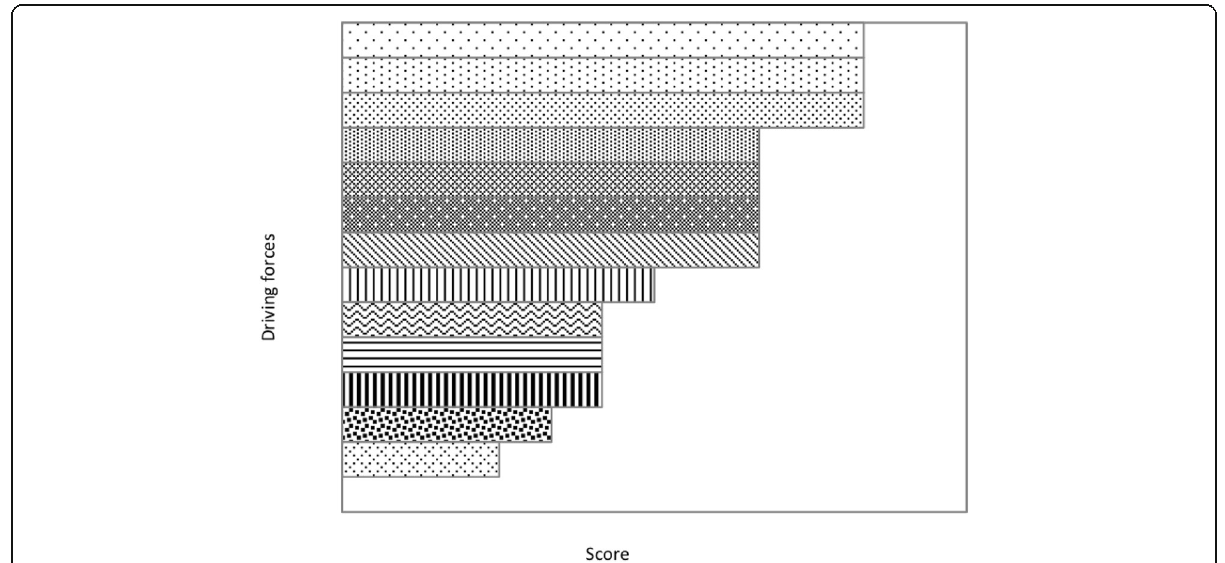
Fig. 5 Major driving forces of LULC changes ranked by focus group